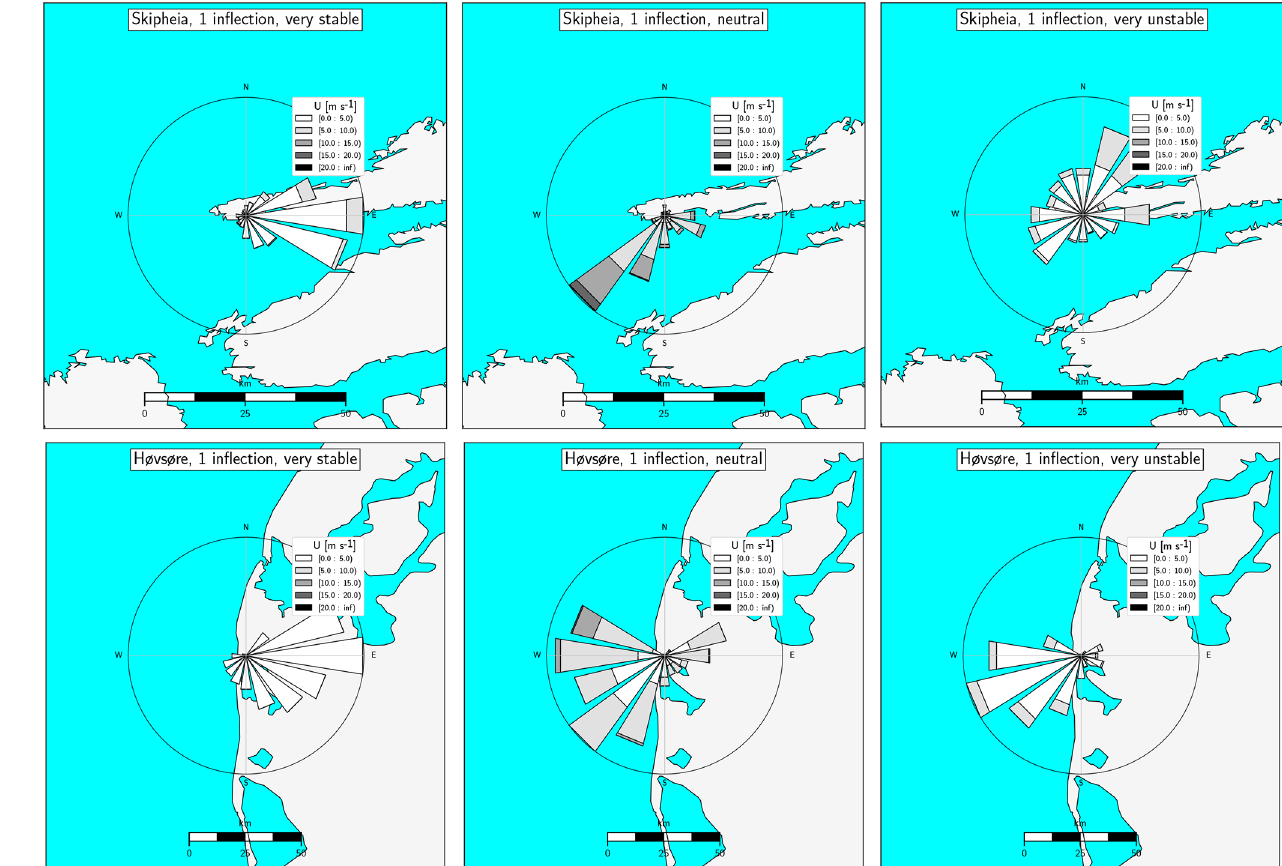
Figure 14. Wind direction of very stable, neutral and very unstable 1-inflection profiles at onshore sites. The wind roses are centered on the site